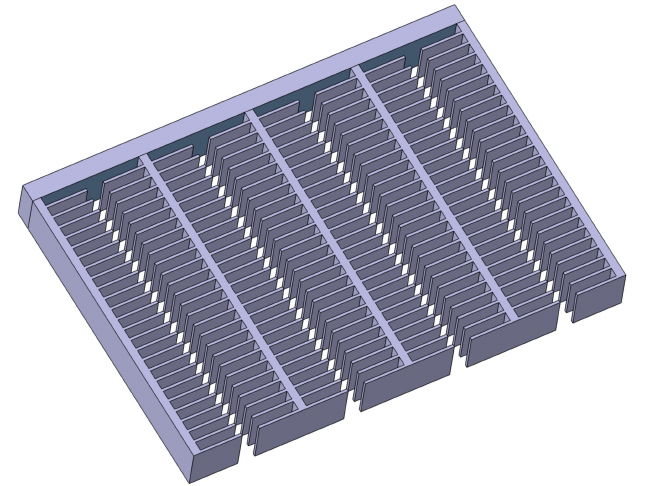
Figure 21. A schematic view of the capacitive converter of the SE of the MEMS gyroscope.